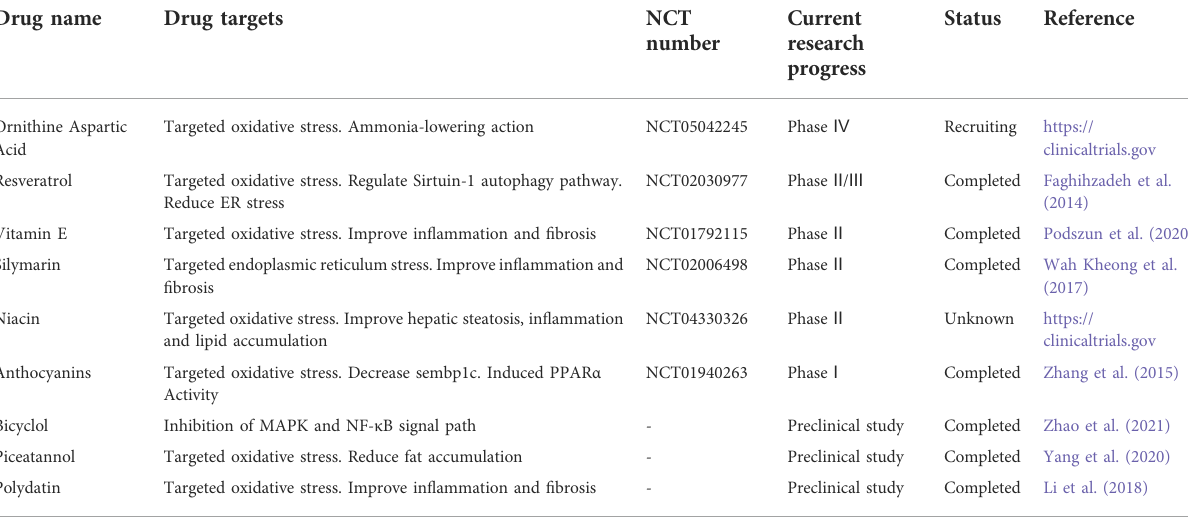
TABLE 2 Mechanism and Research Progress of drugs targeting lipotoxicity and cell